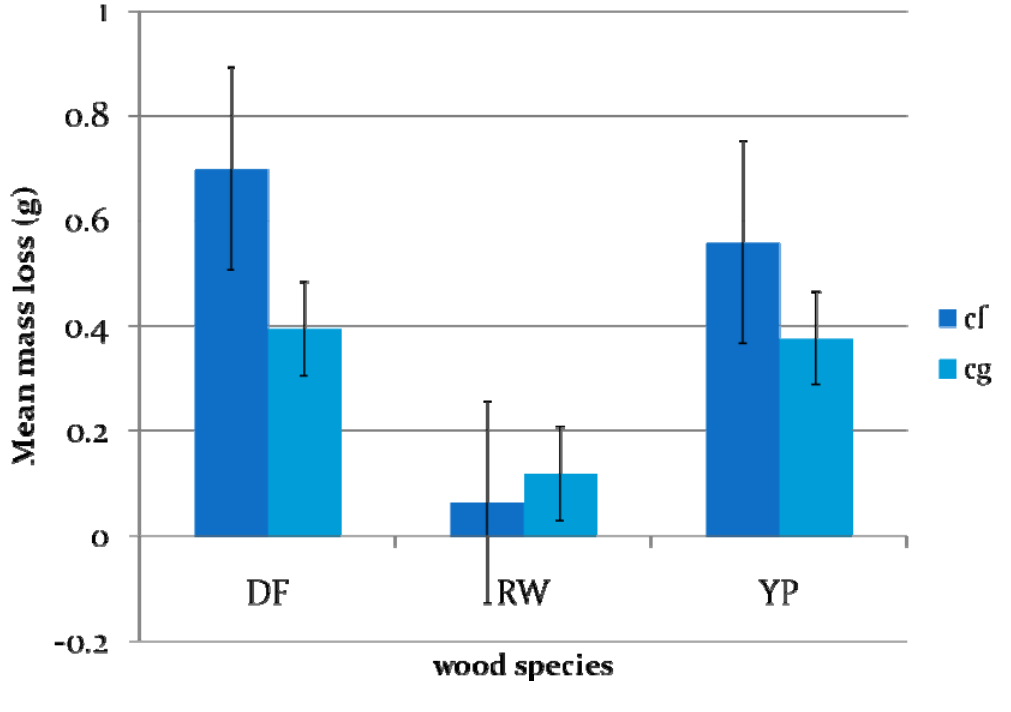
Figure 7. Mean mass loss of three wood species for C. formosanus and C. gestroi. (Two way ANOVA and Ryan-Einot-Gabriel-Welsch Multiple Range Test [REGWQ], P < 0.05) (DF = Douglas fir, YP = Southern Yellow pine, RW=Redwood Cf = Coptotermes formosanus , Cg = Coptotermes gestroi